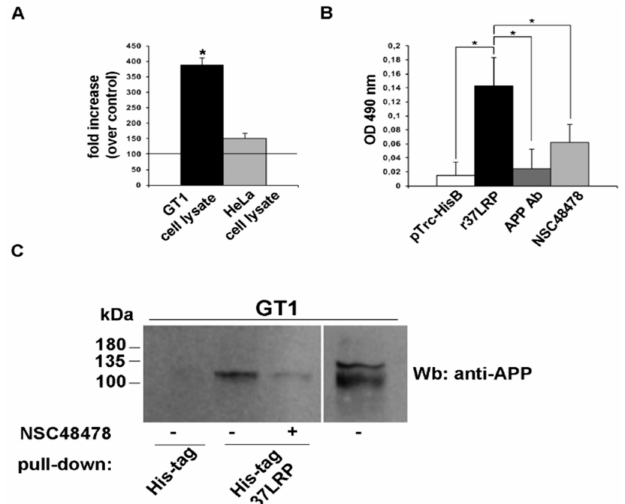
Figure 9. NSC48478 inhibitor a ff ects interaction between APP and 37 / 67 kDa LR in neuronal cells. ( A ) Purified human His-tagged recombinant 37LRP (r37LRP) and control pTrc-His B were placed for 1 h at 37 ◦ C on wells coated with 2 µ g of GT1 or HeLa cell lysates. Bound r37LRP was revealed by anti-His-HRP and OPD staining; the absorbance at 490 nm was measured. r37LRP binding to BSA-coated wells was subtracted to obtain specific binding. Results are expressed as a percent increase of absorbance value over pTrc-His control (horizontal line represents control absorbance value). Values represent the mean ± SEM of three experiments carried out in triplicate; (* p < 0.05). ( B ) Purified human His-tagged recombinant 37LRP (r37LRP) and control pTrc-His B were placed for 1 hour at 37 ◦ C on wells coated with 2 µ g of GT1 cell lysates in the presence of anti-APP antibody, or NSC48478, or DMSO as a vehicle control. Bound r37LRP was revealed by anti-His-HRP and OPD staining; the absorbance at 490 nm was measured. r37LRP binding to BSA-coated wells was subtracted to obtain specific binding. Values represent the mean ± SEM of three experiments carried out in triplicate; (* p < 0.05). ( C ) Lysates from GT1 cells were incubated with agarose-bound recombinant His-tagged 37LRP (His-tag 37LRP) or with agarose bound His-tag (His-tag), as a negative control. His-tag 37LRP conjugated beads were washed, resuspended in Laemmli sample bu ff er, boiled and supernatants were analysed by 15% SDS-PAGE and blotting with anti-APP antibody. Separately, 50 µ g of total GT1 lysate were immunoblotted with anti-APP antibody. Plus ( + ) and minus (-) indicate the presence or absence of